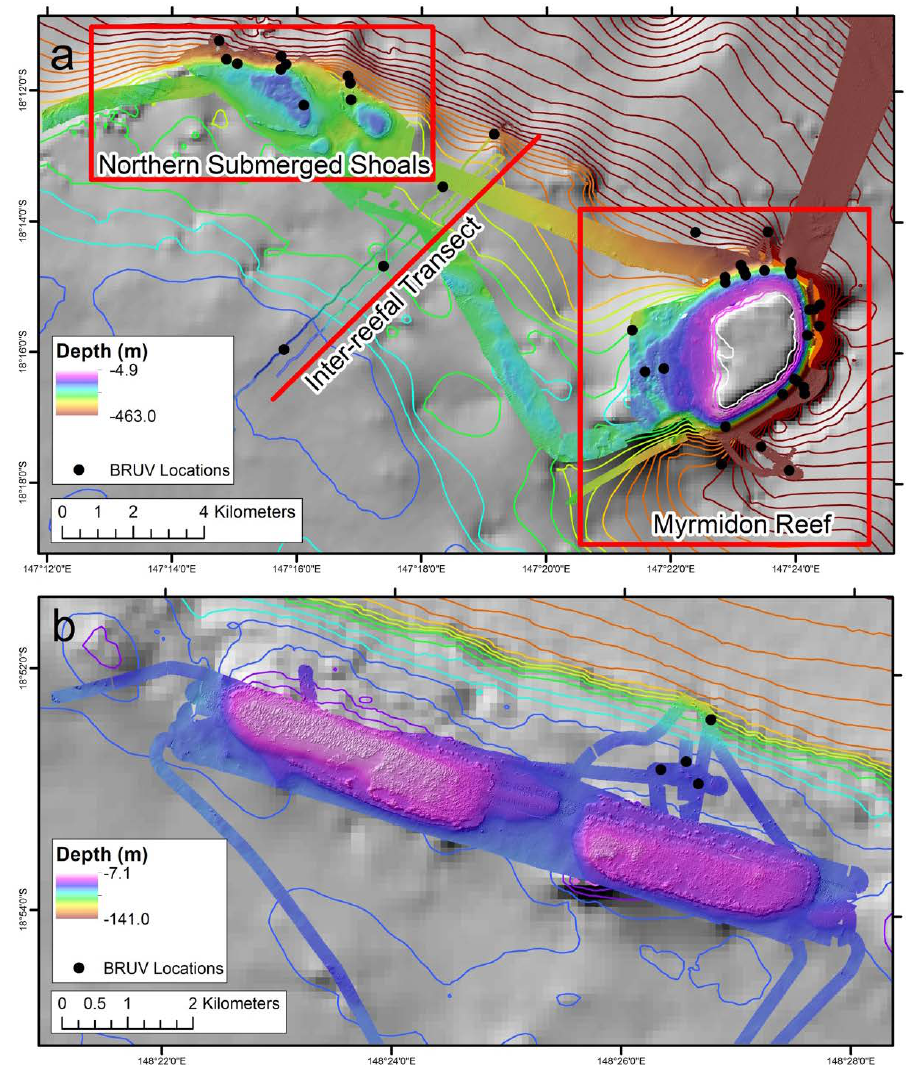
Figure 2. Regional and detailed multibeam bathymetry for ( a ) Myrmidon Reef, an inter-reefal transect, and the adjacent Northern Submerged Shoals, and ( b ) the submerged shoals adjacent to the Viper Reef. Sites of BRUVS deployments are shown as black circles and depth (- meters below the surface from shallower to deeper depths) as a color gradient (from high to low).